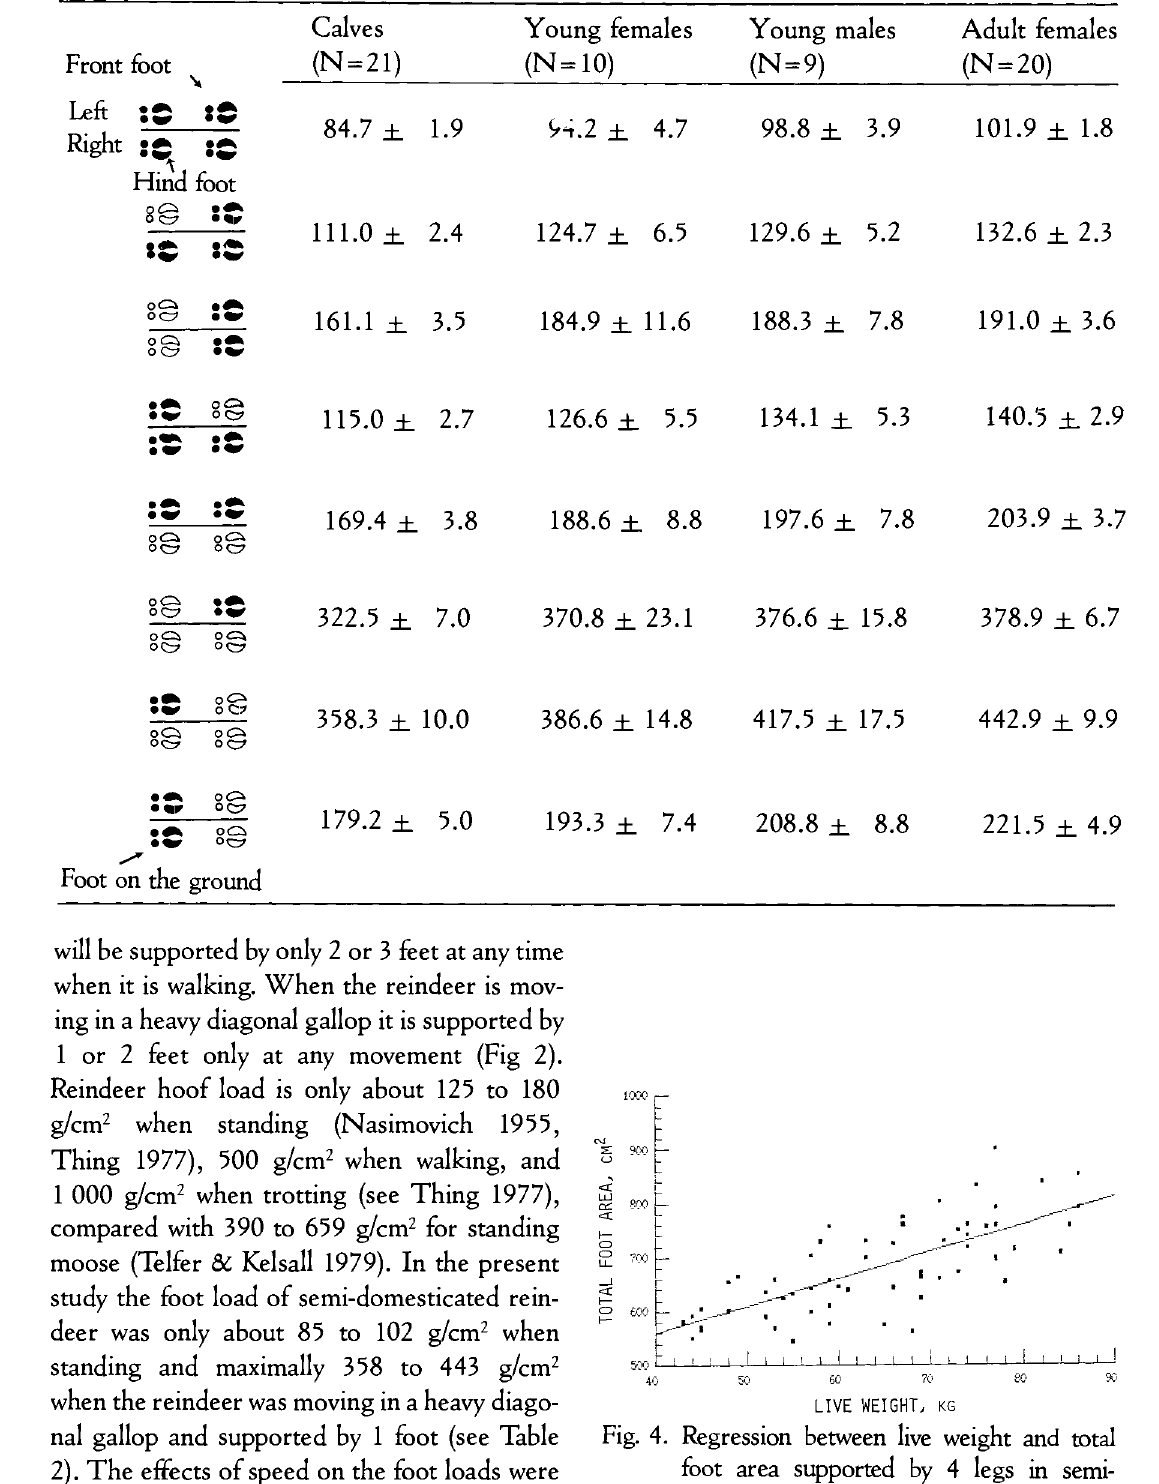
Fig. 4. Regression between live weight and total foot area supported by 4 legs in semi- domesticated reindeer (r = 0.726, n =